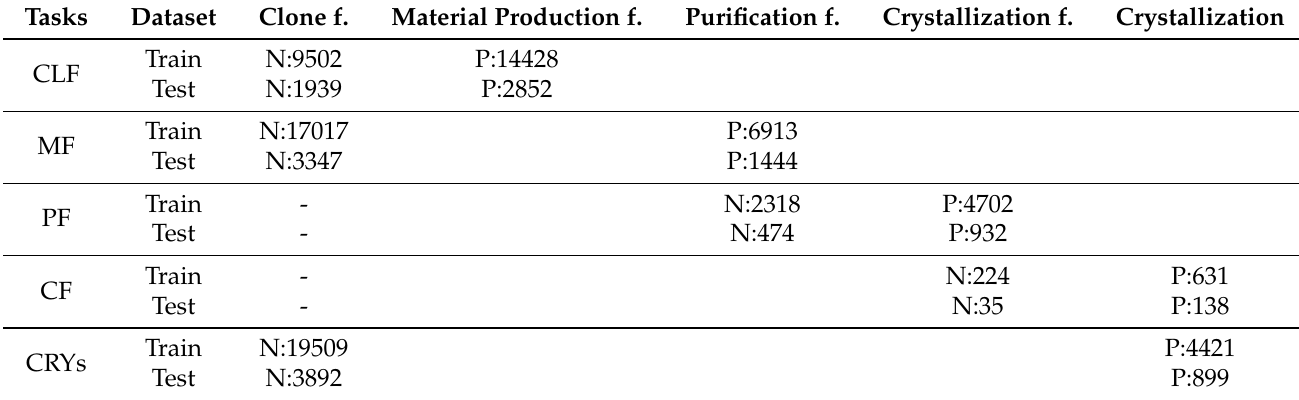
Table 2. Statistics of